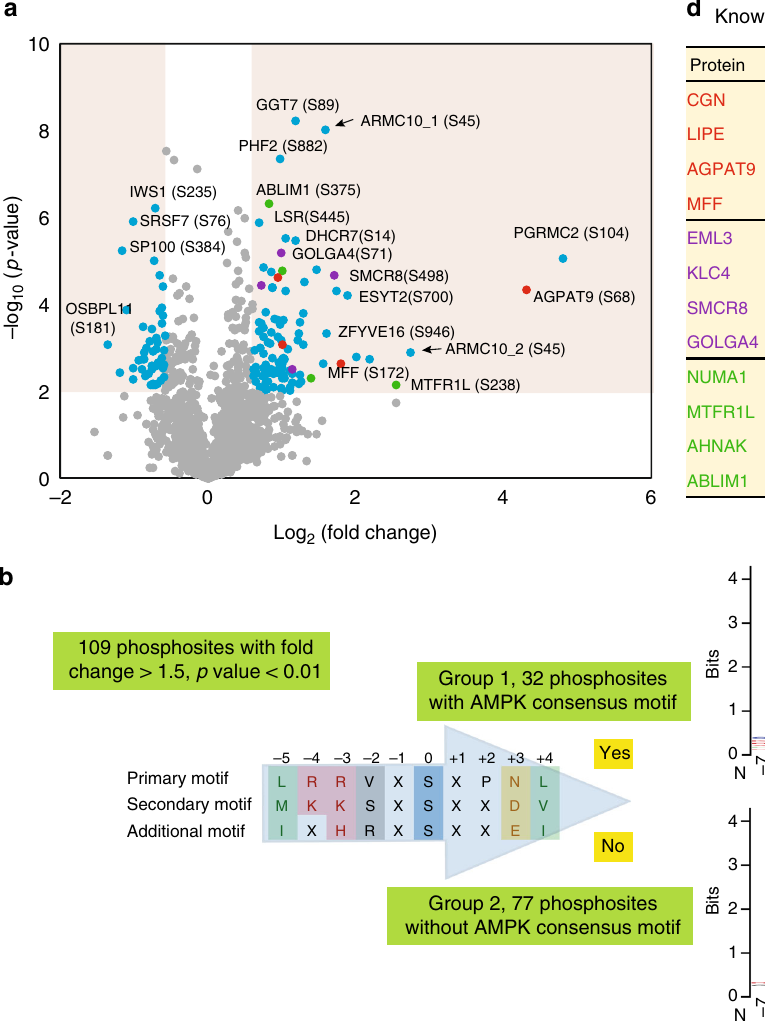
sequences similar to the conserved AMPK substrate motif constituted group 2 ( n = 77). These sites may be regulated by the AMPK-dependent signaling pathways but are not directly phosphorylated by AMPK. The 51 phosphorylation sites that had higher levels of phosphorylation in AMPK α 1/ α 2-DKO cells